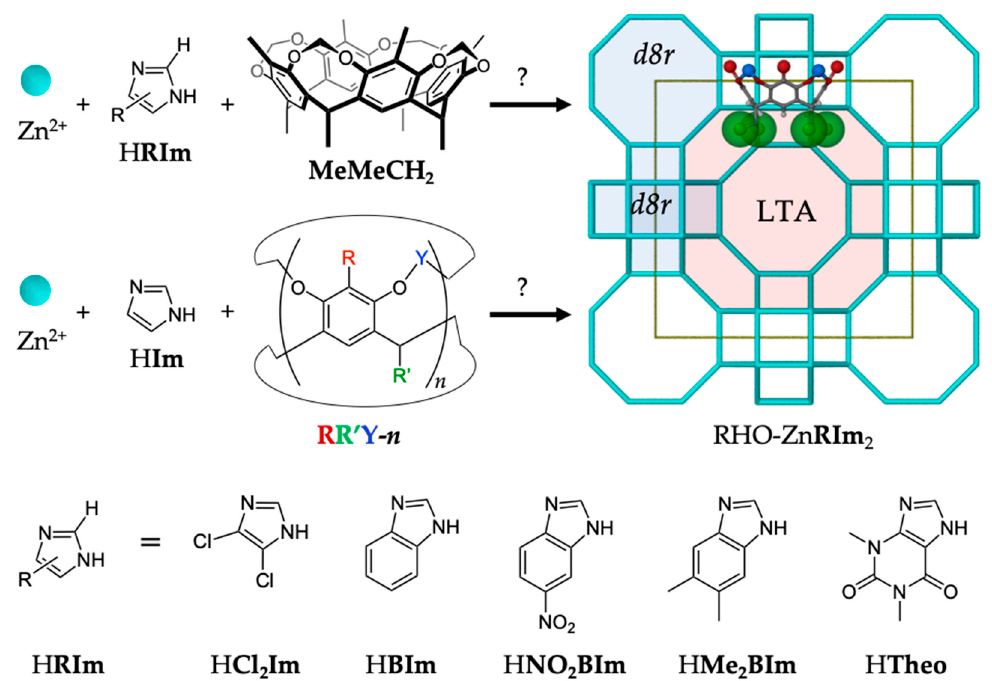
Figure 2. Exploration of the scope of the templation of the RHO topological form of zinc imidazolates, using different cavitands (see Table 1) and